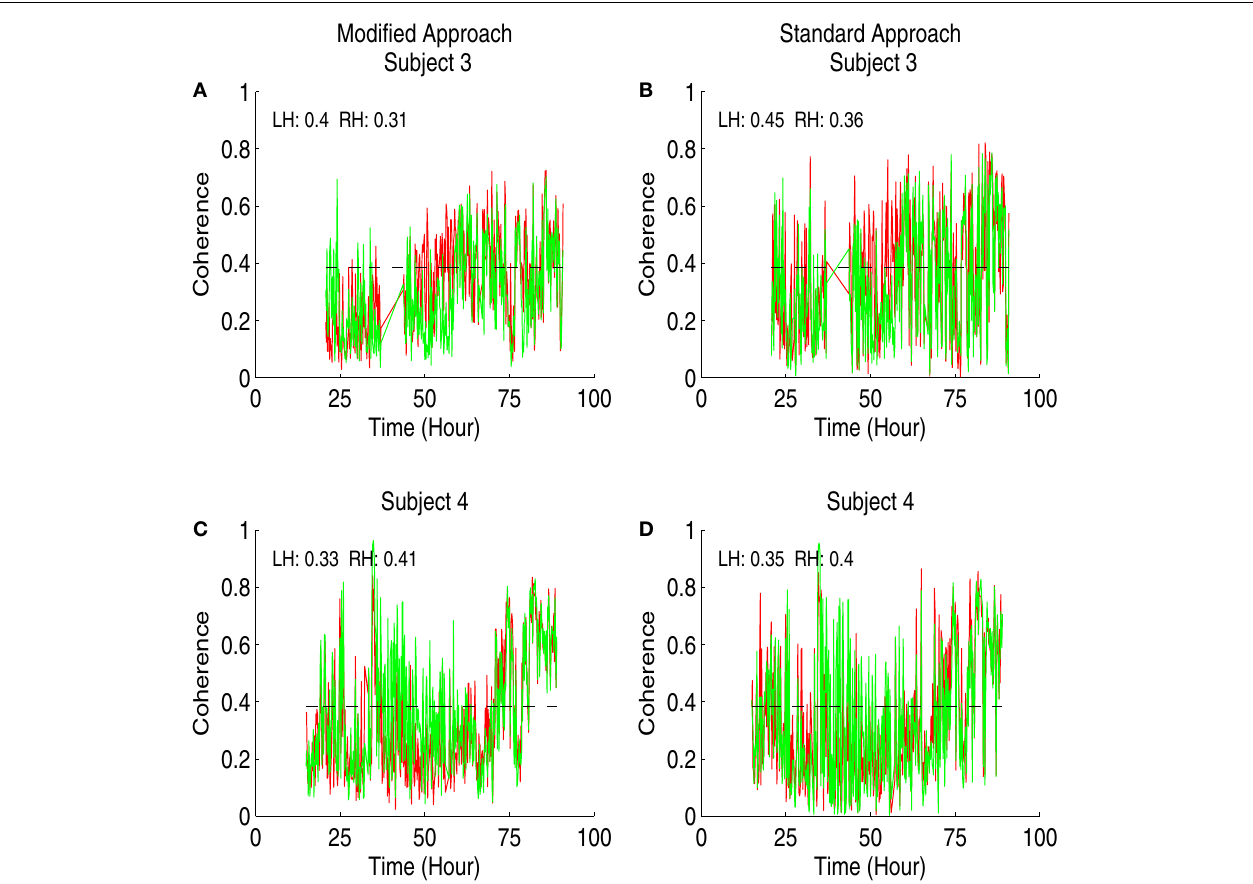
shown in (A,B) and the results from subject 4 were shown in (C,D) . In all the plots, the results from the left hemisphere (LH) were shown in red and the results from the right hemisphere (RH) were shown in green. Also the pressure passivity index (PPI) calculated for LH and RH was given in the inset. The horizontal line at the coherence value of 0.384 is the confidence limit for the coherence